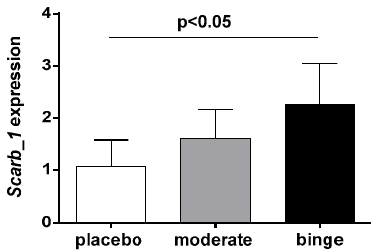
Figure 5. Effect of moderate and binge alcohol consumption on hepatic Scarb1 gene expression. RNA was isolated from liver, as described in the Methods Section. Scarb1 mRNA levels were determined by quantitative RT-PCR. Hprt was used as housekeeping gene for the normalization of Scarb1 gene expression. Data are expressed as mean ± SD ( n = 3–4 per group). Results were analyzed using one-way ANOVA followed by Tukey’s multiple comparison test among groups.